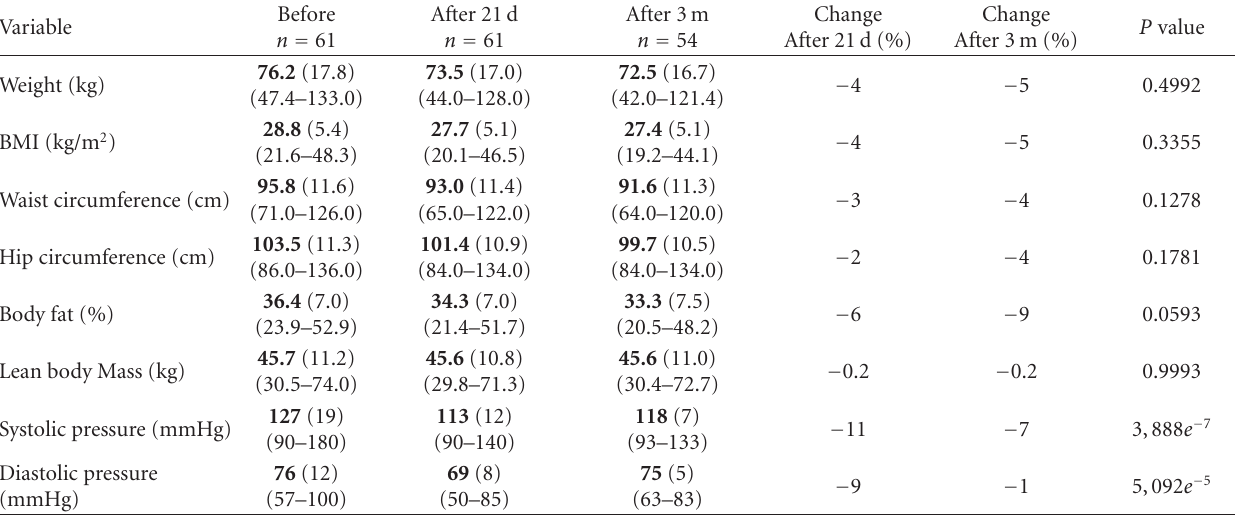
Table 2: Changes of anthropometric variables and arterial blood pressure during 3-month intervention with Ma-Pi 2 macrobiotic diet in type 2 diabetic adults.